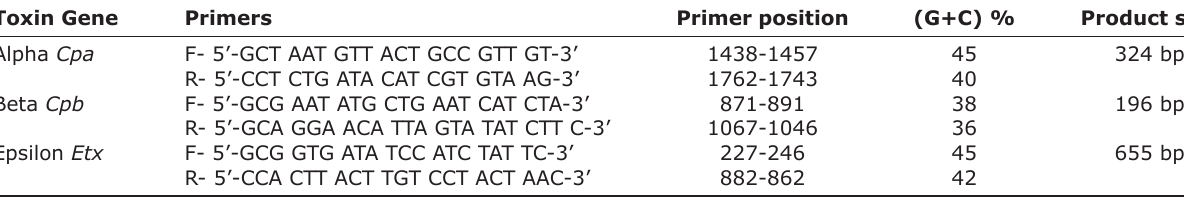
Table-1: Primers used for multiplex PCR in the preset study. Toxin